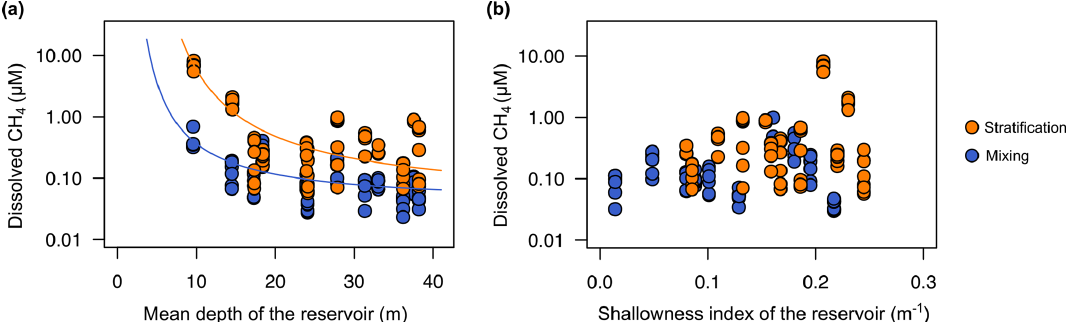
Figure 6. Reservoir morphometry and the dissolved CH 4 concentration in the oxic zone. (a) Exponential decay relationships of the dissolved CH 4 concentration and the mean depth (m) during the stratification period (CH 4 = 4 . 0 × 10 − 2 e ( 50 . 0 / mean depth ) , n = 78, adjusted R 2 = 0 . 95) and the mixing period (CH 4 = 3 . 7 × 10 − 2 e ( 22 . 9 / mean depth ) , n = 82, adjusted R 2 = 0 . 54). (b) Scatterplot of dissolved CH 4 concentration and the reservoir shallowness index during the stratification period ( p value = 0.134) and the mixing period ( n = 0 . 114). More statistical details can be found in Table S2.